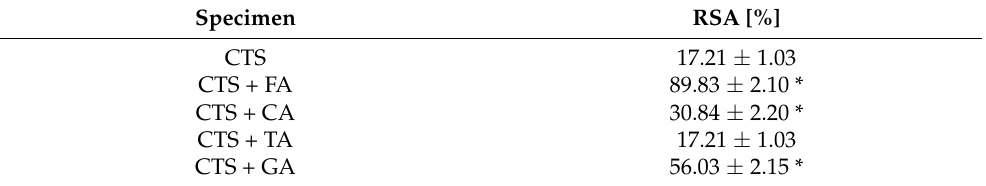
Table 4. Antioxidant activity (RSA%) of chitosan-based films modified by phenolic acids (* signifi- cantly different from CTS— p < 0.05).